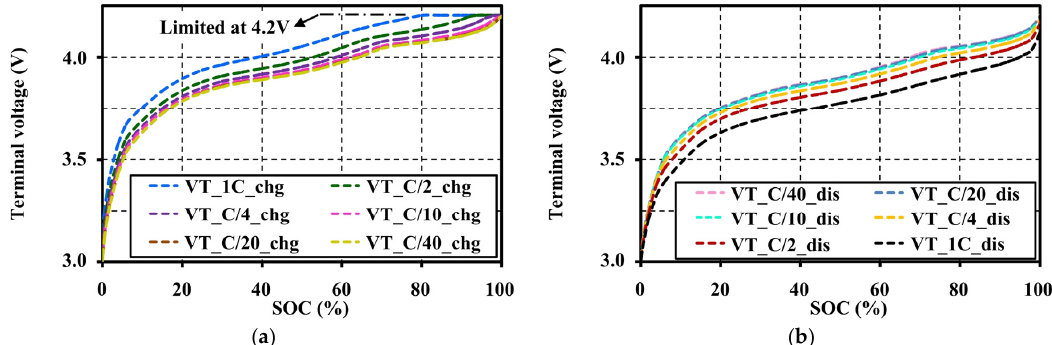
Figure 12. Effects of current amplitudes on the terminal voltage characteristic at 20 °C: ( a ) under continuous charging; and ( b ) under continuous discharging.